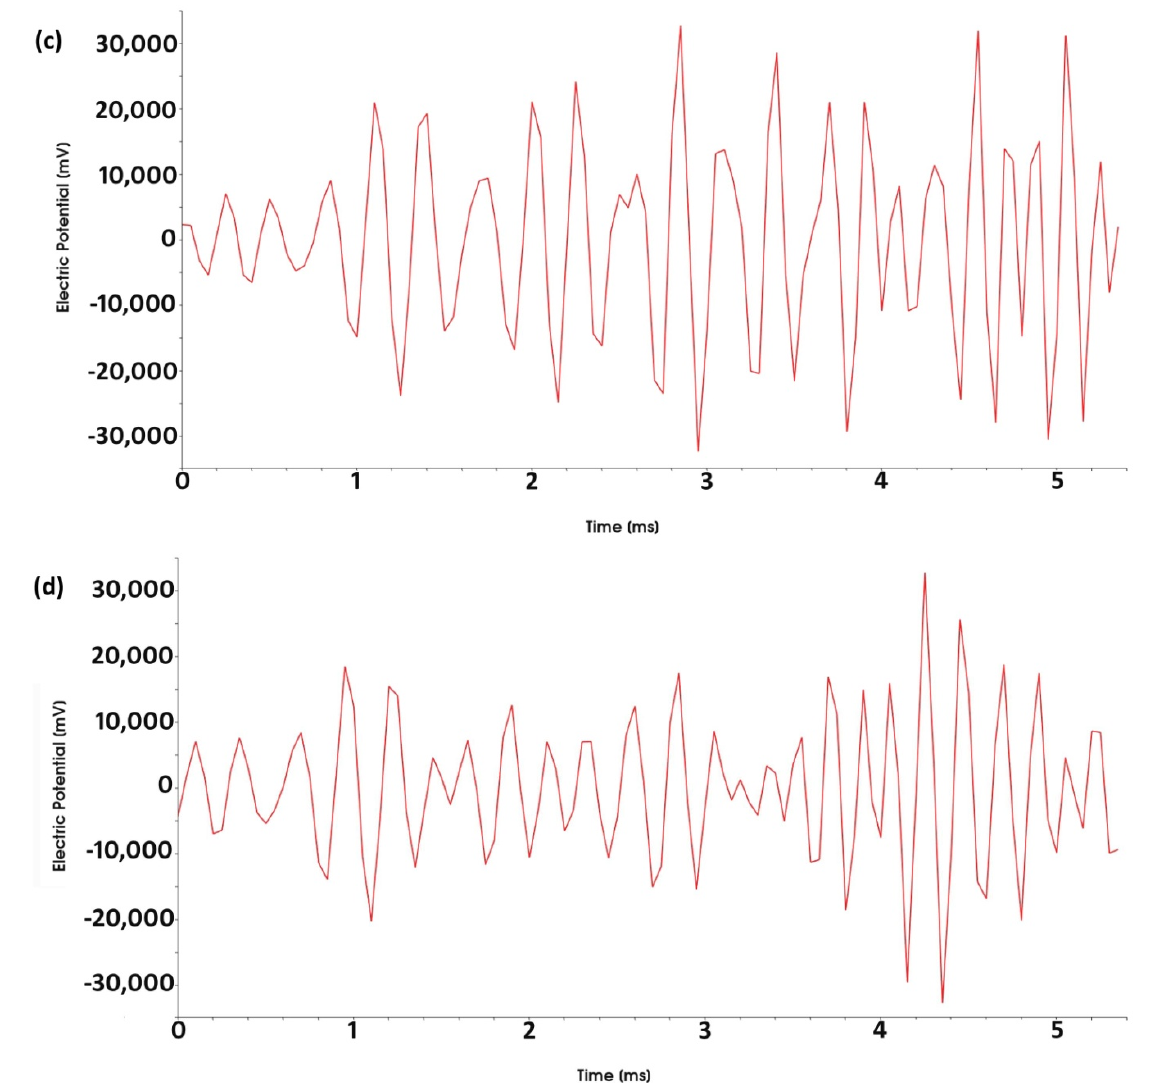
Figure 3. Enlarged signatures of first arrival of the reflected signal. ( a ) Site 1—sand. ( b ) Site 2—sand. ( c ) Site 3—Sandstone. ( d ) Site